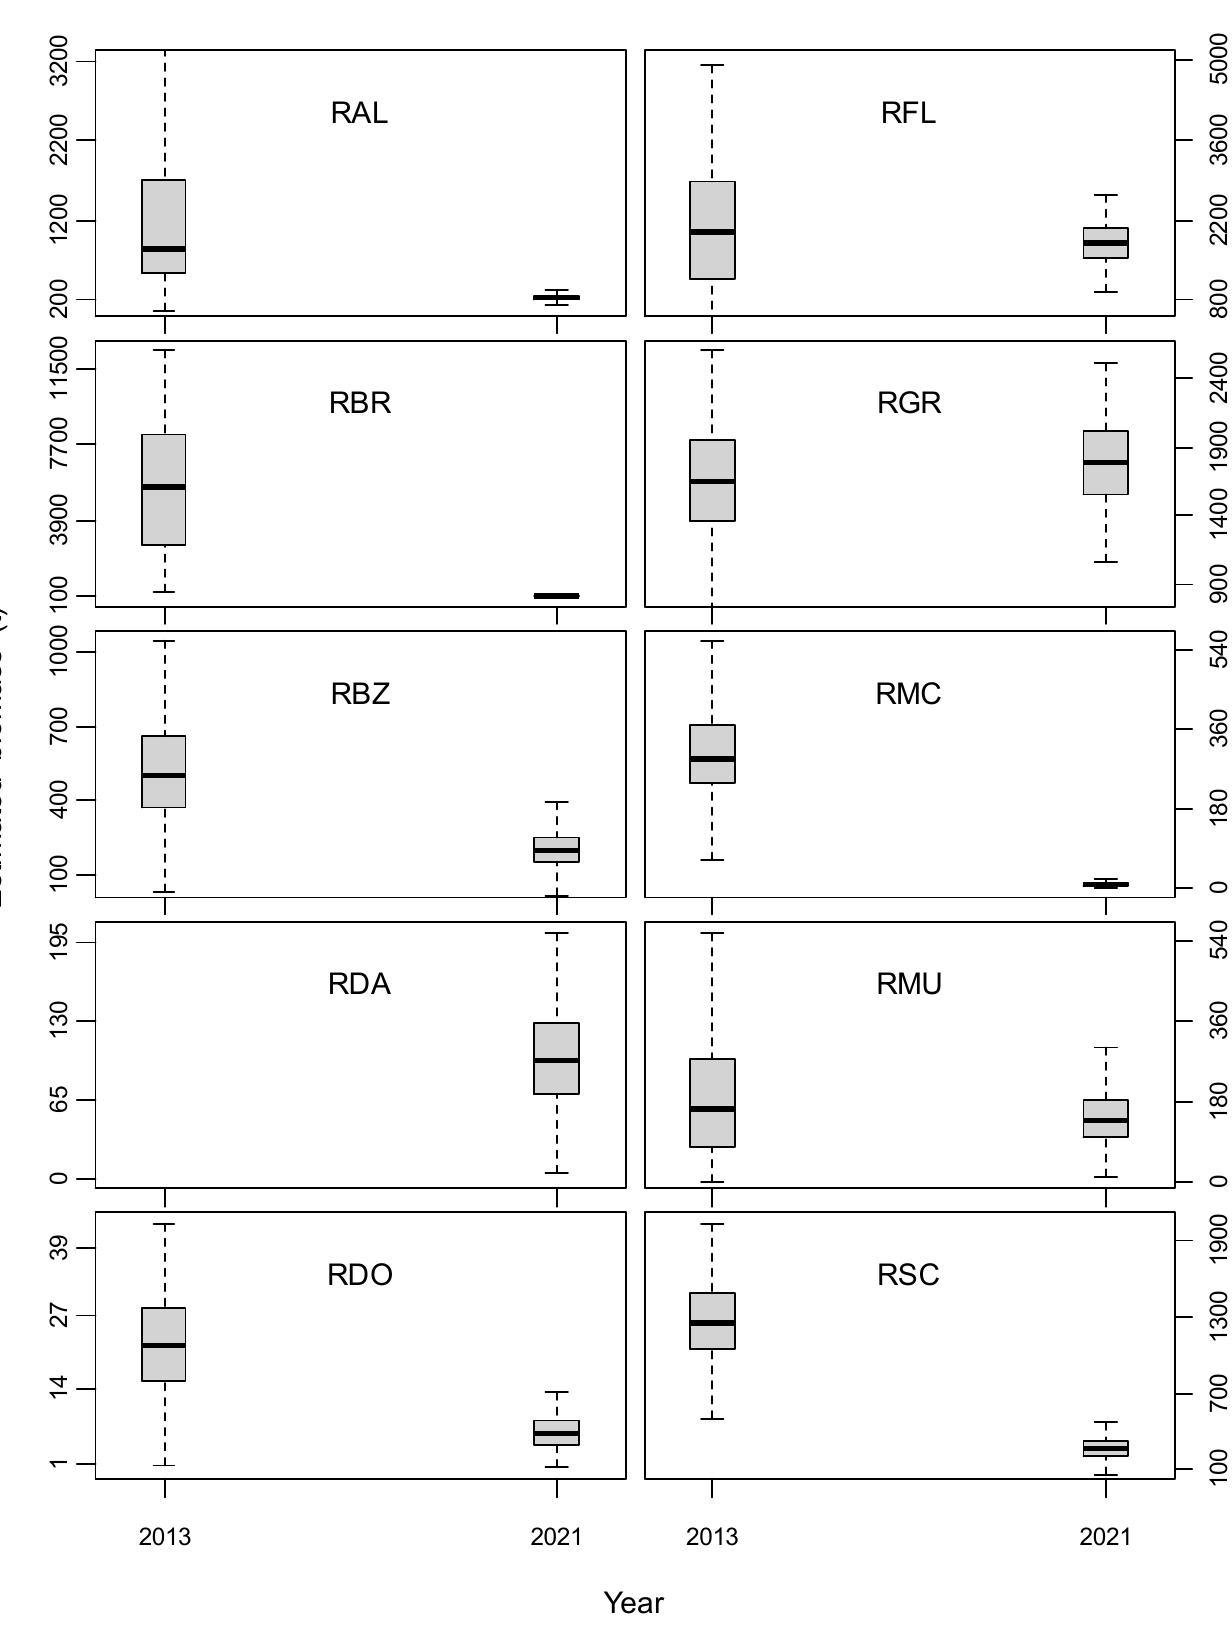
under-shading: 95% confidence interval of the inter-annual GAM from randomized resampling. Falkland Islands species codes correspond to Table 2.